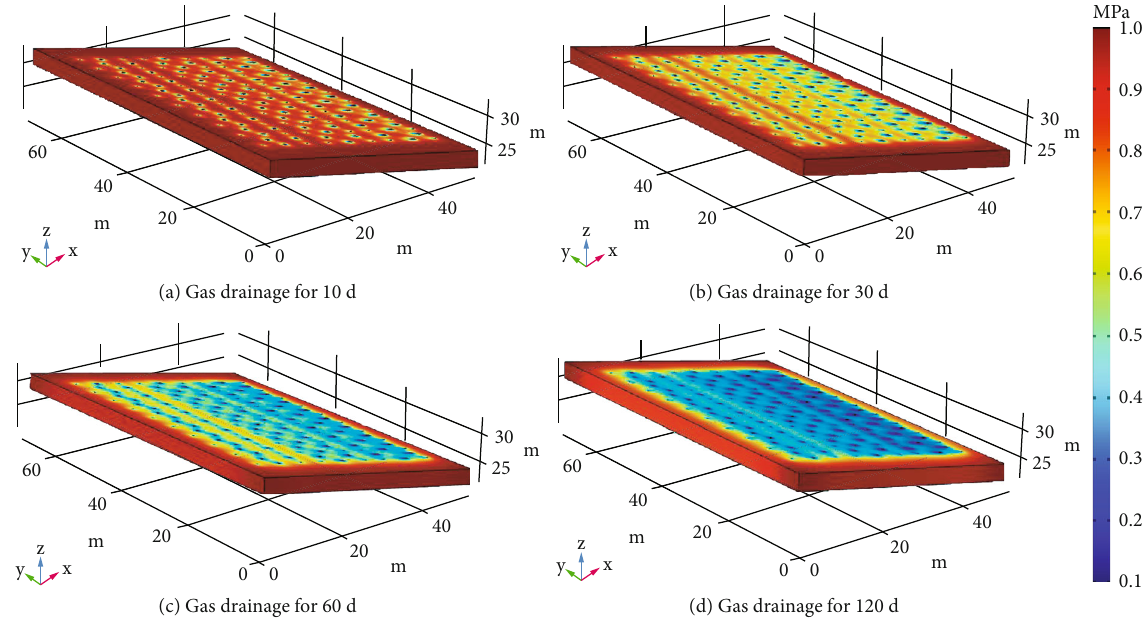
Figure 6: Gas pressure distributions in coal seam before roadway